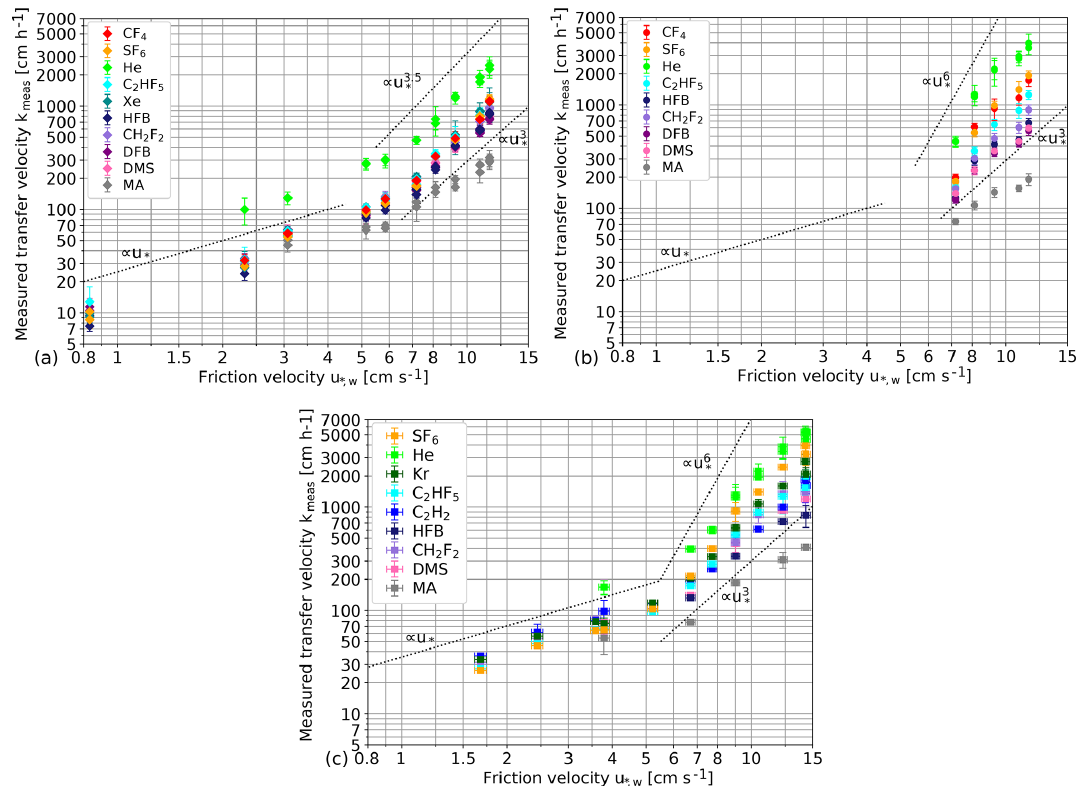
Figure 6. Measured gas transfer velocities k meas in fresh water in Kyoto (a) , in the seawater model in Kyoto (b) and in seawater in Miami (c) . Tracers in the legend are sorted by increasing solubility. As a visual guide, lines showing exponential proportionalities between the transfer velocity and the friction velocities to varying powers are